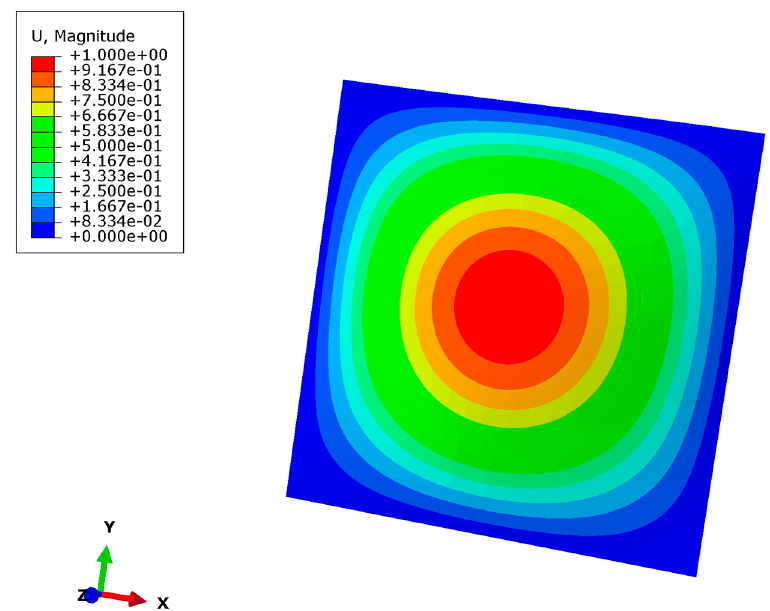
Figure 5. Linear buckling displacement response simulation of Cu plates.